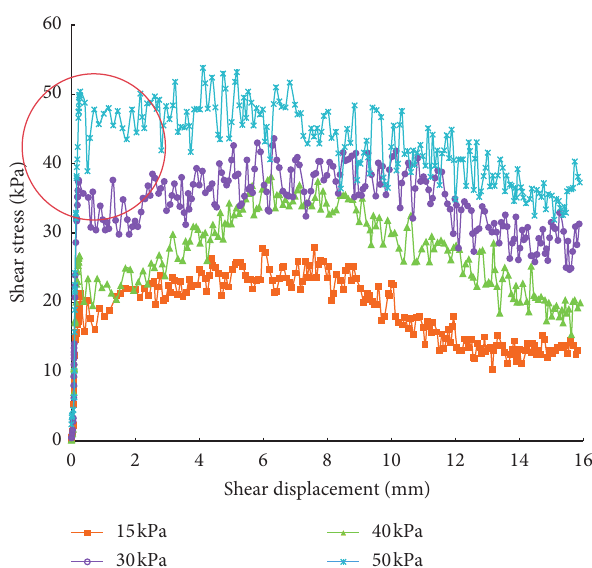
Figure 11: Shear stress-shear displacement curve of 0.4cm horizontal ring-shaped-reinforced sand.